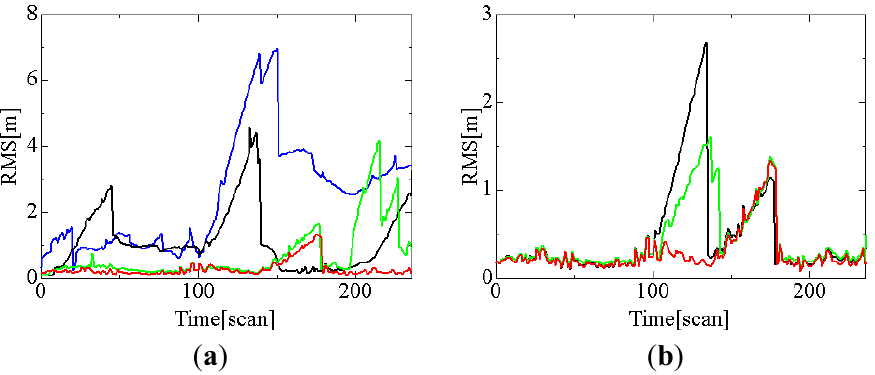
Figure 8. Tracking error. ( a ) Effect of data association method and tracking mode. ( b ) Effect of data fusion method. In (a), red, green, blue and black lines indicate the results by cooperative tracking using GNN, individual tracking using GNN, cooperative tracking using NN, and individual tracking using NN, respectively. In (b), red, green and black lines indicate the results by CI, Kalman filter and averaging method,